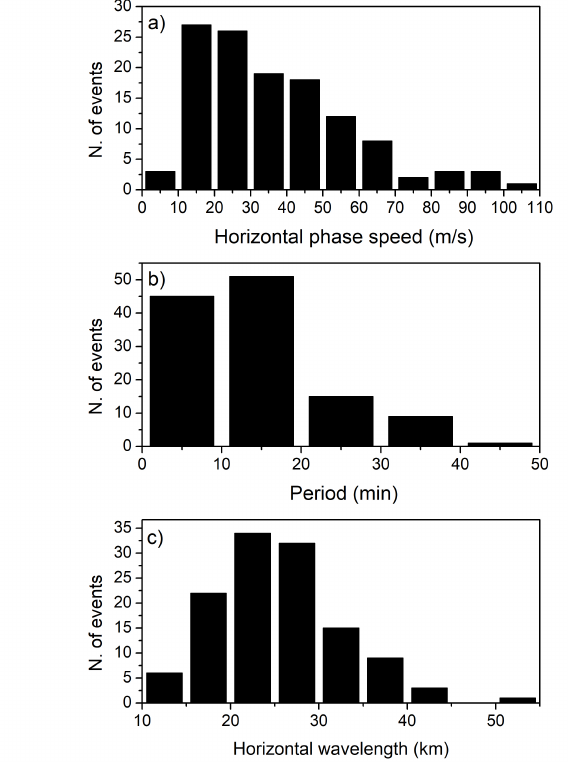
Figure 6. Histogram of gravity wave characteristics: ( a ) horizontal phase speed, ( b ) observed period and ( c ) horizontal